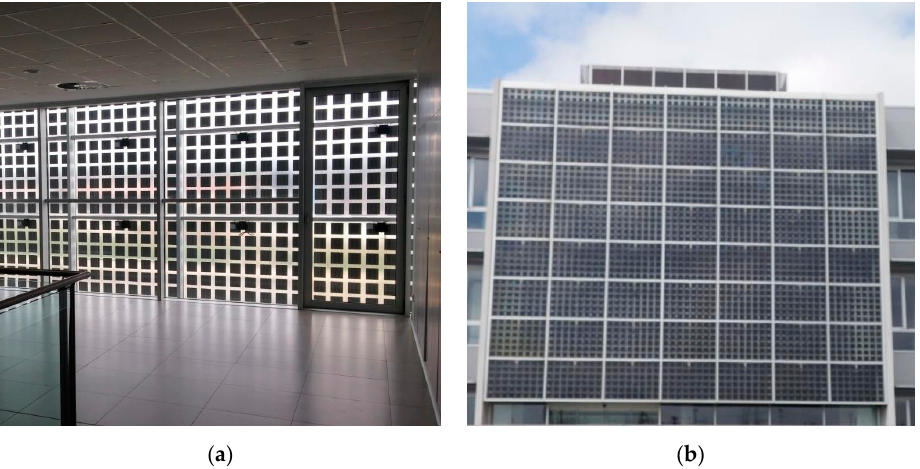
Figure 1. View of the ventilated façade with photovoltaic (PV) modules ( a ) from indoors and ( b ) from outdoors.